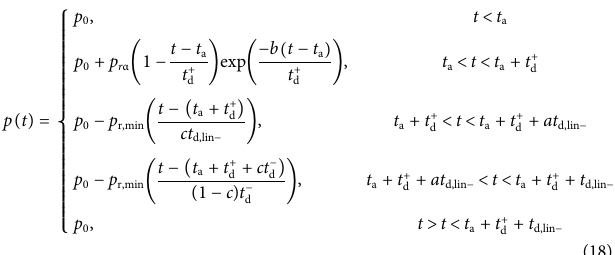
Frontiers in Materials |